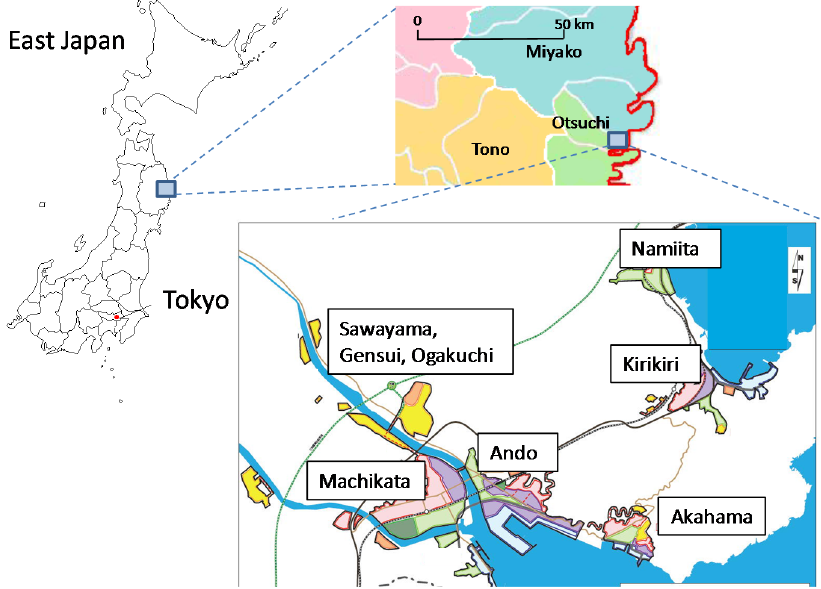
Figure 1. Map of Otsuchi Town. The Otsuchi community map was compiled from the Otsuchi Reconstruction Plan (2013).